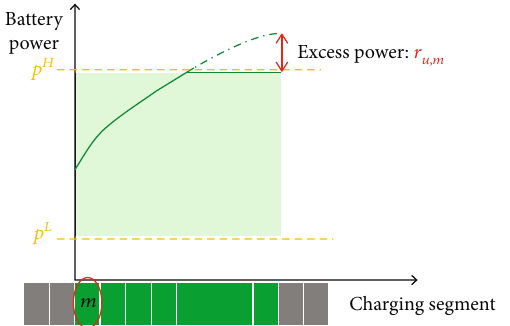
Figure 5: Diagram of excess power.